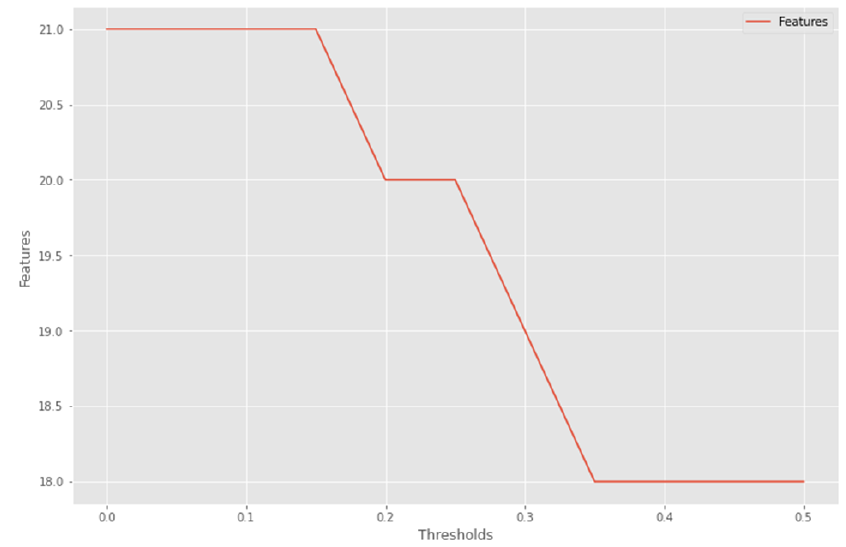
Figure 2. Line Plot of Variance Threshold (X) Versus Number of Selected Features to be removed (Y).